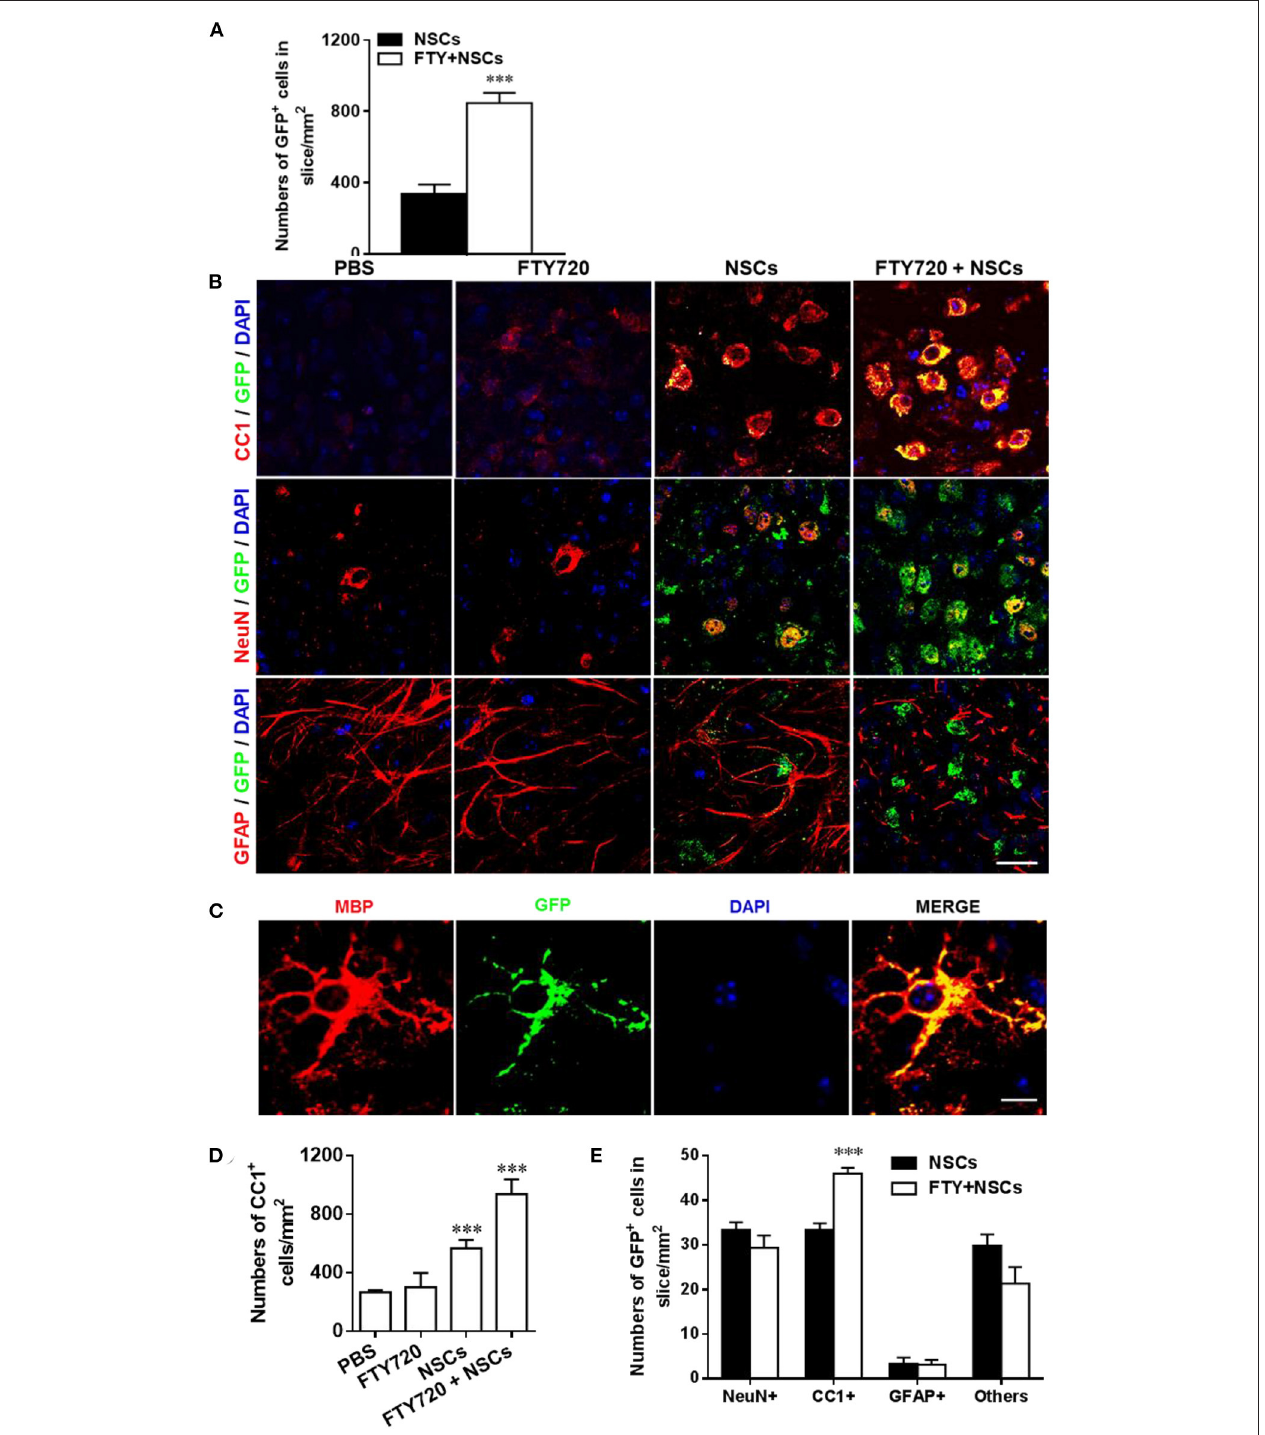
FIGURE 2 | Impact of FTY720 plus NSC treatment on neural cell lineages in brain slice culture model. Brain slices obtained from newborn (P0-3) C57/Bl6 mouse pups were grown for 3 days in culture, and NSCs (2 µ l, ∼ 5 × 10 4 cells /slice) and/or FTY720 (1nM) were added for the subsequent 7 days; the slices were then fixed and immunostained. (A) Quantitative analysis of the number of transplanted NSCs (GFP + ) in brain slices. (B) Immunofluorescence images of brain slices. Cells co-labeled with GFP and neural specific markers (red) were identified as differentiated cells derived from NSCs (yellow); cells positive only for neural-specific markers (red) were endogenous cells. CC1 + : oligodendrocytes, NeuN + : neurons, GFAP + , astrocytes. Scale bar = 20 µ m. (C) High-magnification confocal images show that GFP (green) was highly colocalized with the oligodendrocyte marker MBP (red). Scale bar = 10 µ m. (D) Quantification of total CC1 + cell numbers. (E) Quantitative